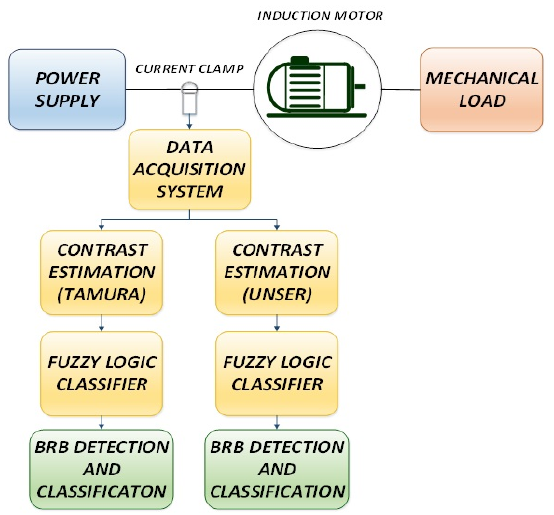
Figure 4. Proposed methodology for BRB detection.